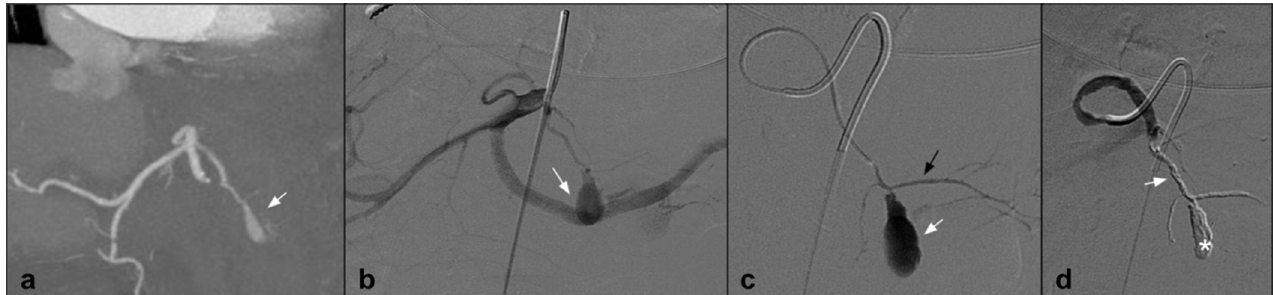
Figure 4. ( a ) Coronal CTA MIP demonstrates post surgical pseudoaneurysm of left gastric artery (white arrows). ( b ) DSA performed with Simmons 1 catheter at the level of the ostium of the celiac trunk confirms the presence of the pseudoaneurysm (white arrow). ( c ) DSA performed with microcatheter in the left gastric artery highlights a saccular dilation (white arrow) of the left gastric artery with regular patency of the efferent vessel (black arrow). ( d ) Post-procedure DSA control demonstrates complete exclusion of the treated PSA (asterisk) with an Onyx 18 cast completely occupying the malacic vessel performing an “endovascular ligature technique” (white arrow).